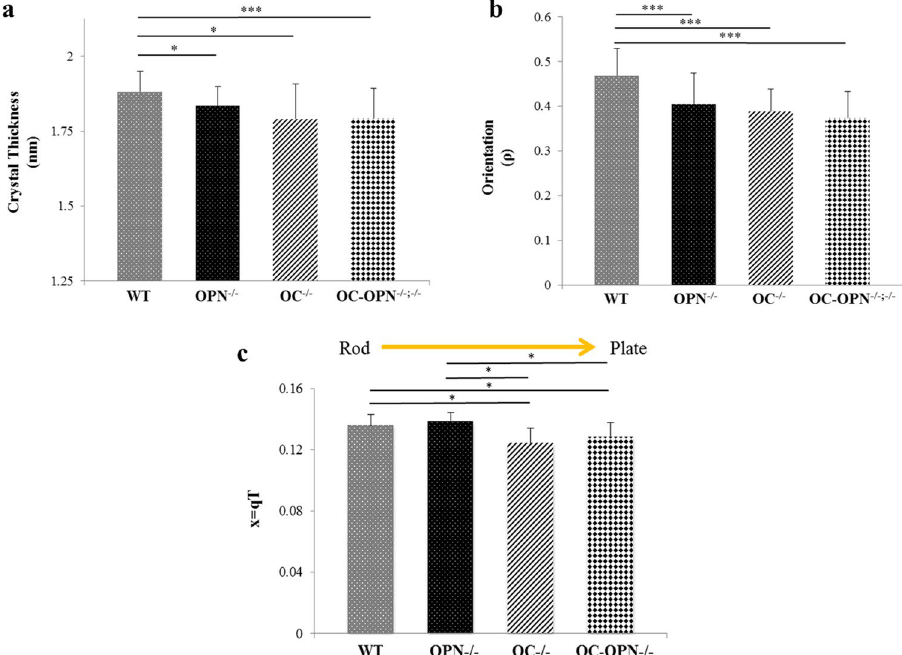
Figure 1. ( a ) Mineral crystal thickness for all genotypes ( * and ** denote p < 0.05 and p < 0.01 respectively as determined by ANOVA post-hoc SNK test). No differences were observed between the knock-out groups. ( b ) Mineral crystal orientation for all genotypes. ( *** denotes p < 0.001 as determined by ANOVA post hoc SNK test). If ρ = 0, the crystals have no predominant orientation within the plane of the section. As ρ increases, crystals are increasingly aligned along the collagen fibril; ρ = 1 implies all crystals are aligned along the principal axis (fibril direction). ( c ) Values of x for all four genotypes. Shape changes from rod-like to plate-like as shown. Values of x for rod-like WT and OPN − / − are significantly different (p < 0.05, One-way ANOVA post hoc SNK test) from those of plate-like OC − / − and OC-OPN − / − ; − / −